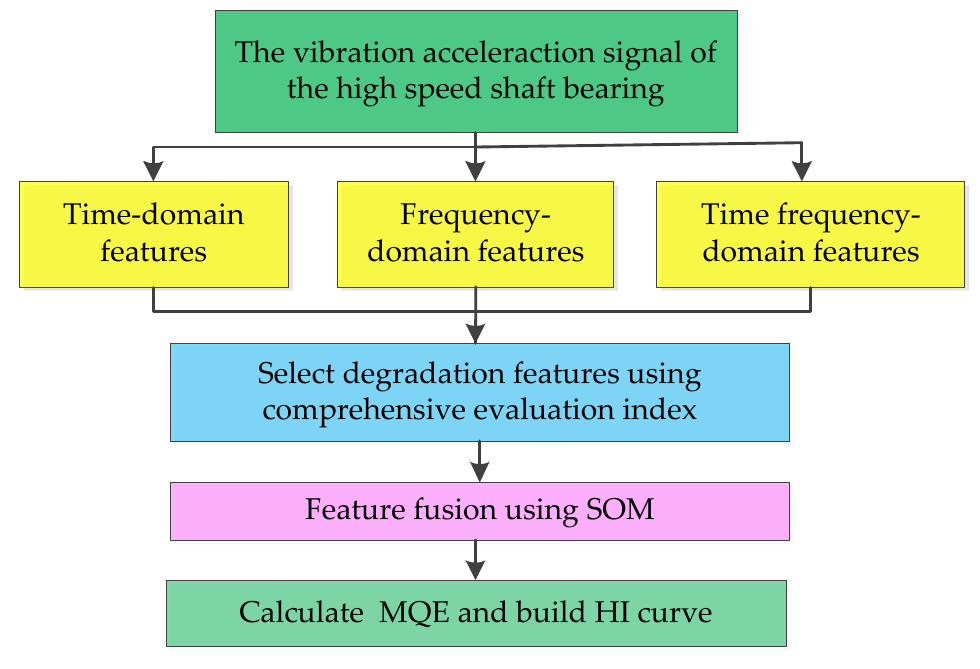
Figure 1. Flow chart for constructing HI curve.